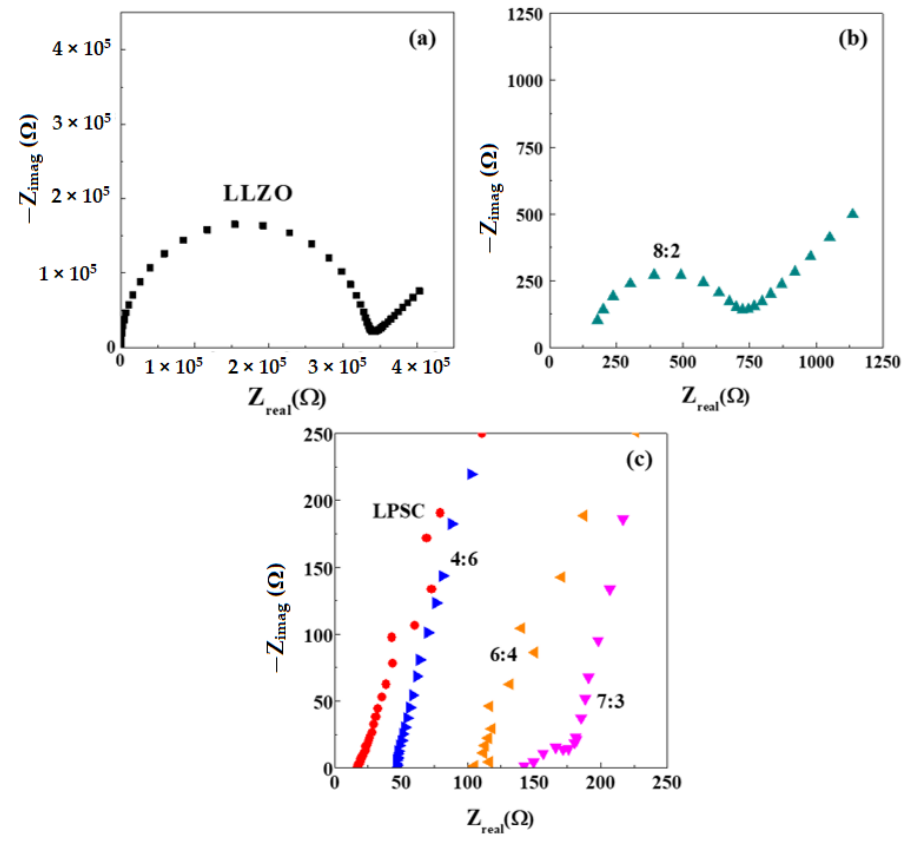
Figure 4. Impedance spectra of symmetrical cells with solid electrolytes ( a ) of LLZO, at ( b ) LLZO:LPSC = 8:2, at ( c ) LLZO:LPSC = 7:3, 6:4, 4:6, and of LPSC. Table 1. Room temperature (25 ◦ C) ionic conductivities of LLZO, LLZO-LPSC composite, and LPSC electrolytes.